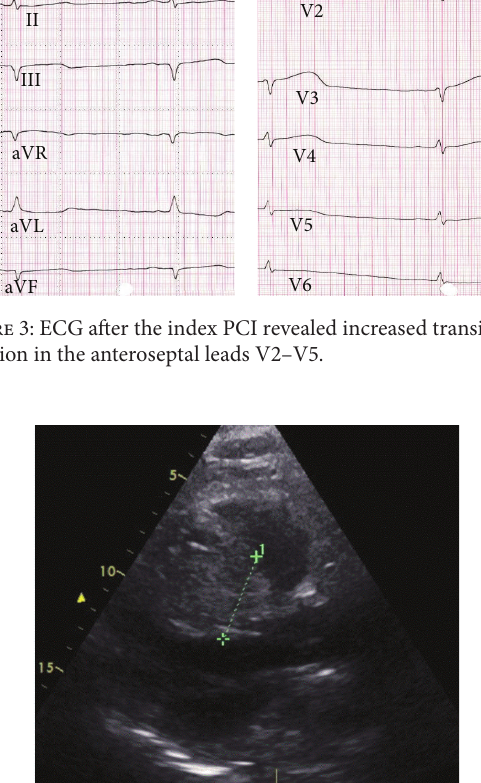
Figure 2: Coronary angiography after predilation and implantation of four drug eluting stents in the right coronary artery showed acceptable result.